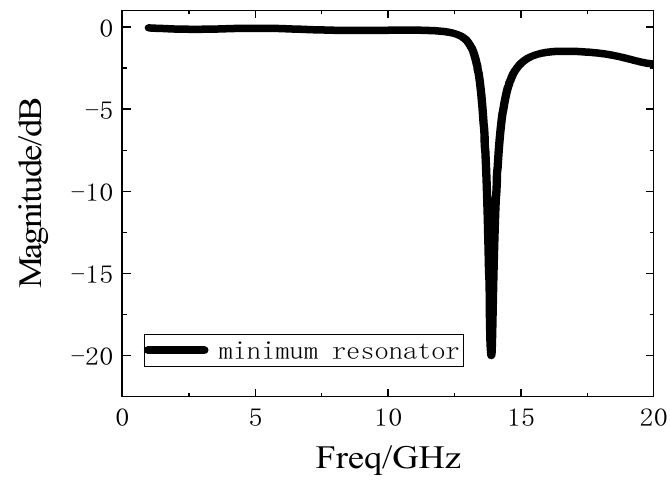
Figure 19. The minimum resonators of the 31-bit retransmitted chipless tag. Table 2 lists the performance comparisons of various types of retransmission chipless tags. The U-shaped slot resonator chipless tags proposed in this paper are simple in design, with high Q-value and small size. The capacity is 1.03 bits/cm 2 . The spectral capacity number of bits C apacity ( bits / cm (cid:2870) ) = (10) size( cm (cid:2870) )